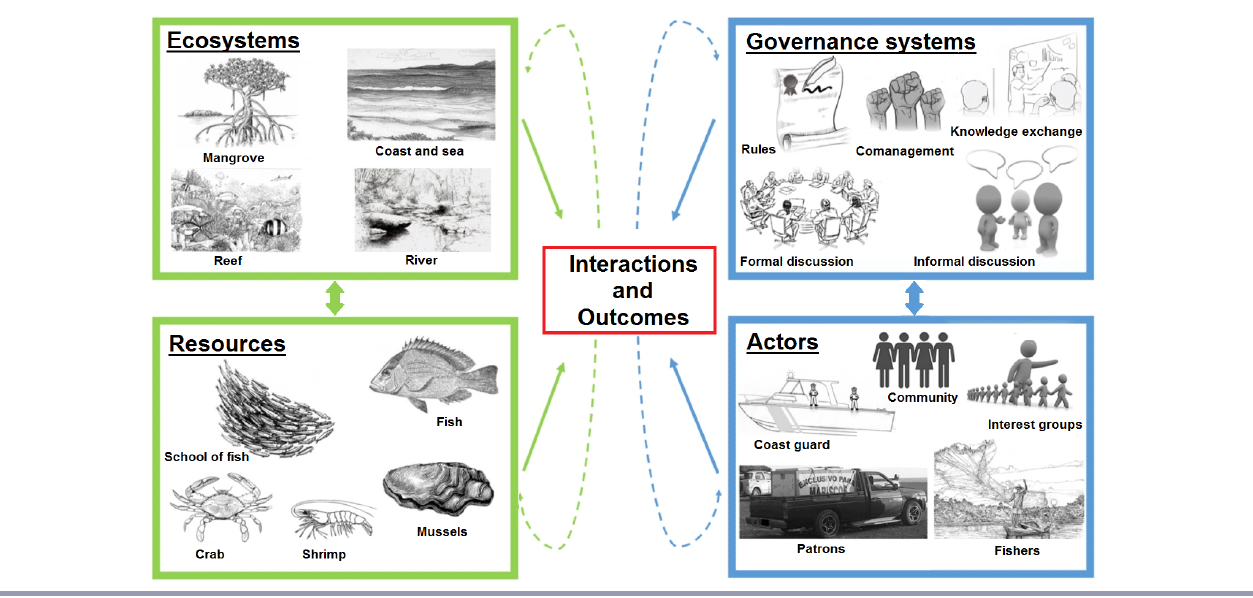
Fig. 4 . An image-based social-ecological system framework (SESF) transformed for use by fishers in the Gulf of Nicoya, Costa Rica. The image-based framework translates the general concept of systems thinking and social-ecological interactions through simple images and text.